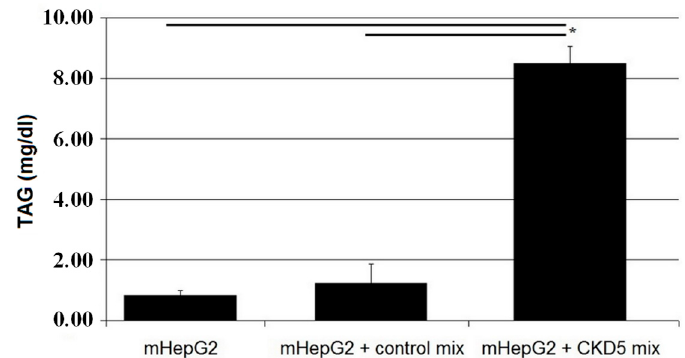
Figure 4. Concentration of TAG in culture medium after 48 h incubation with FA mixtures. Data are shown as mean ± SEM, * p < 0.05. Table 3. Content of fatty acids in extracts from patients with chronic kidney disease (CKD) stage 5 and healthy controls serum mixes used for hepatocyte treatment in vitro. The data are presented as a fatty acid proportion (%). SFA—saturated fatty acids, MUFA—monounsaturated fatty acids, PUFA— polyunsaturated fatty acids.